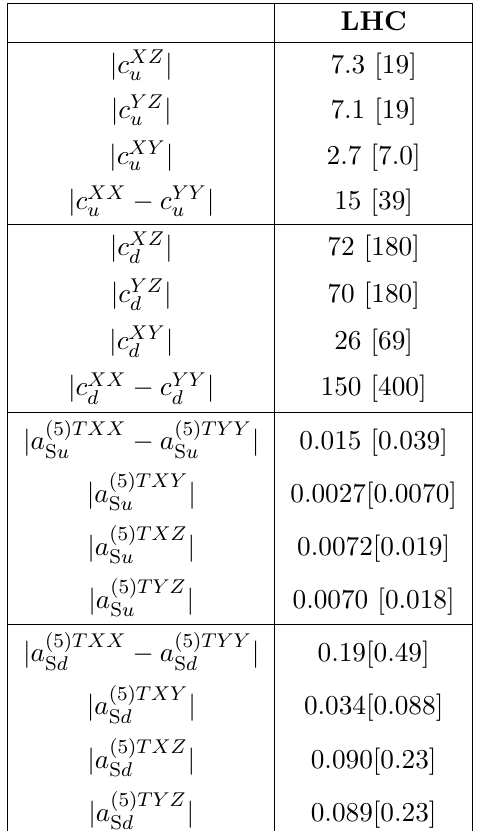
and a (5) TJK from studies of f S f